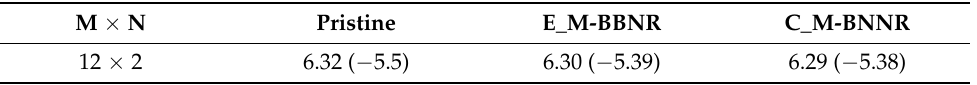
Table 1. Cohesive energy per atom (and Gibbs free energy) in eV of the pristine BNNR and M-BNNR.